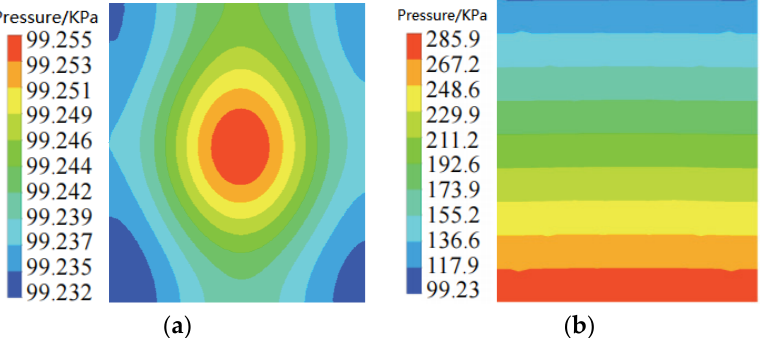
Figure 29. Pressure distribution at the inlet of the turbine [119]. ( a ) Without considering the free surface; ( b ) considering the free surface.